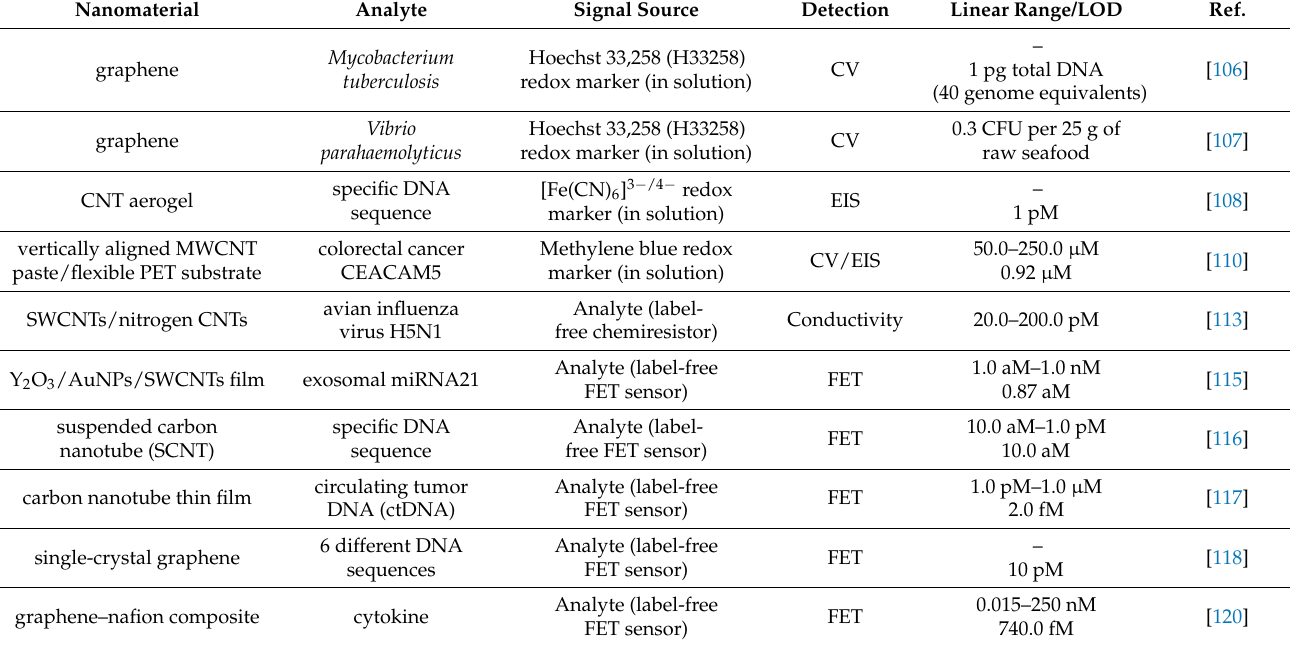
Table 3. Examples of application of carbon nanomaterials as transducers or their components and independent layers in chemiresistor- and FET-based DNA